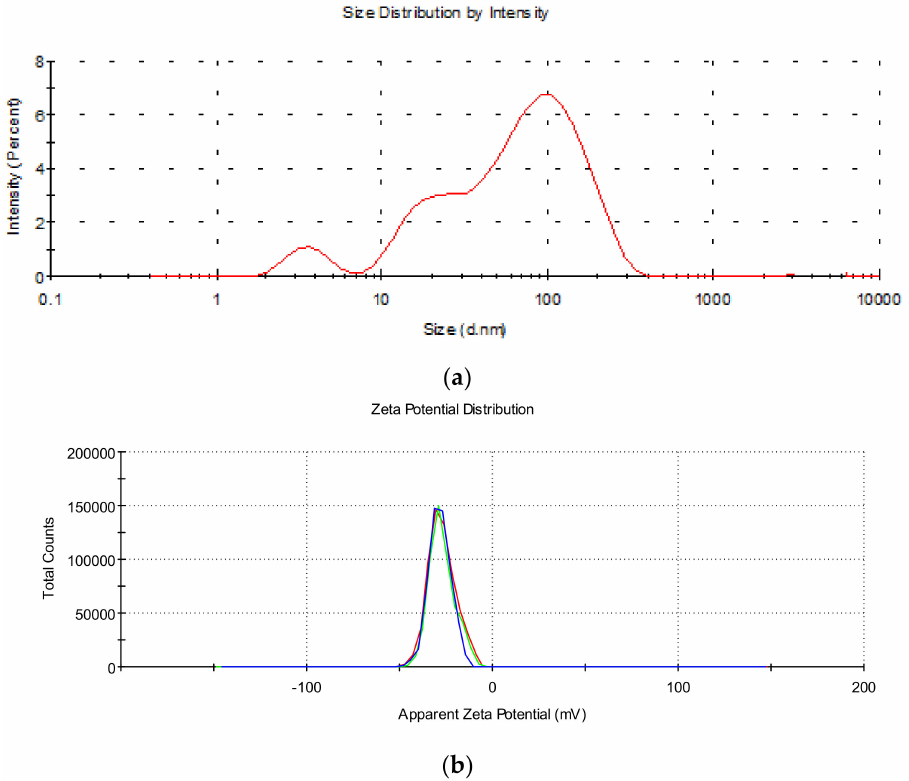
Figure 5. ( a ) DLS spectra of silver nanoparticles showing size distribution in the solution. ( b ) Zeta potential of synthesized silver